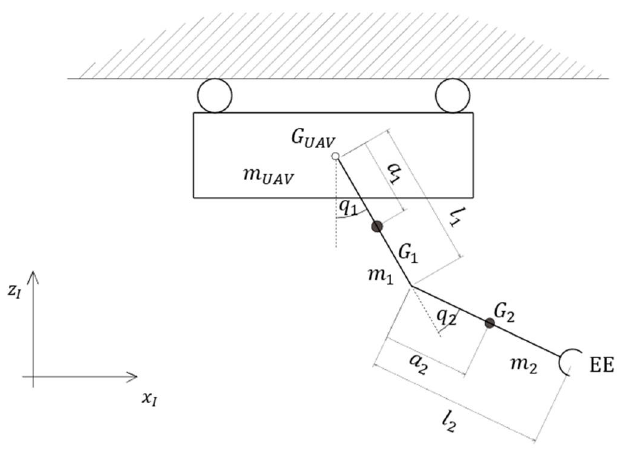
Figure 5. Model for the ideal 2-DOF trolley case.